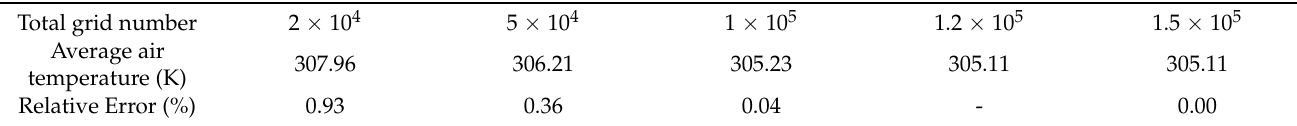
Table 3. Grid independence verification ( P = 1000